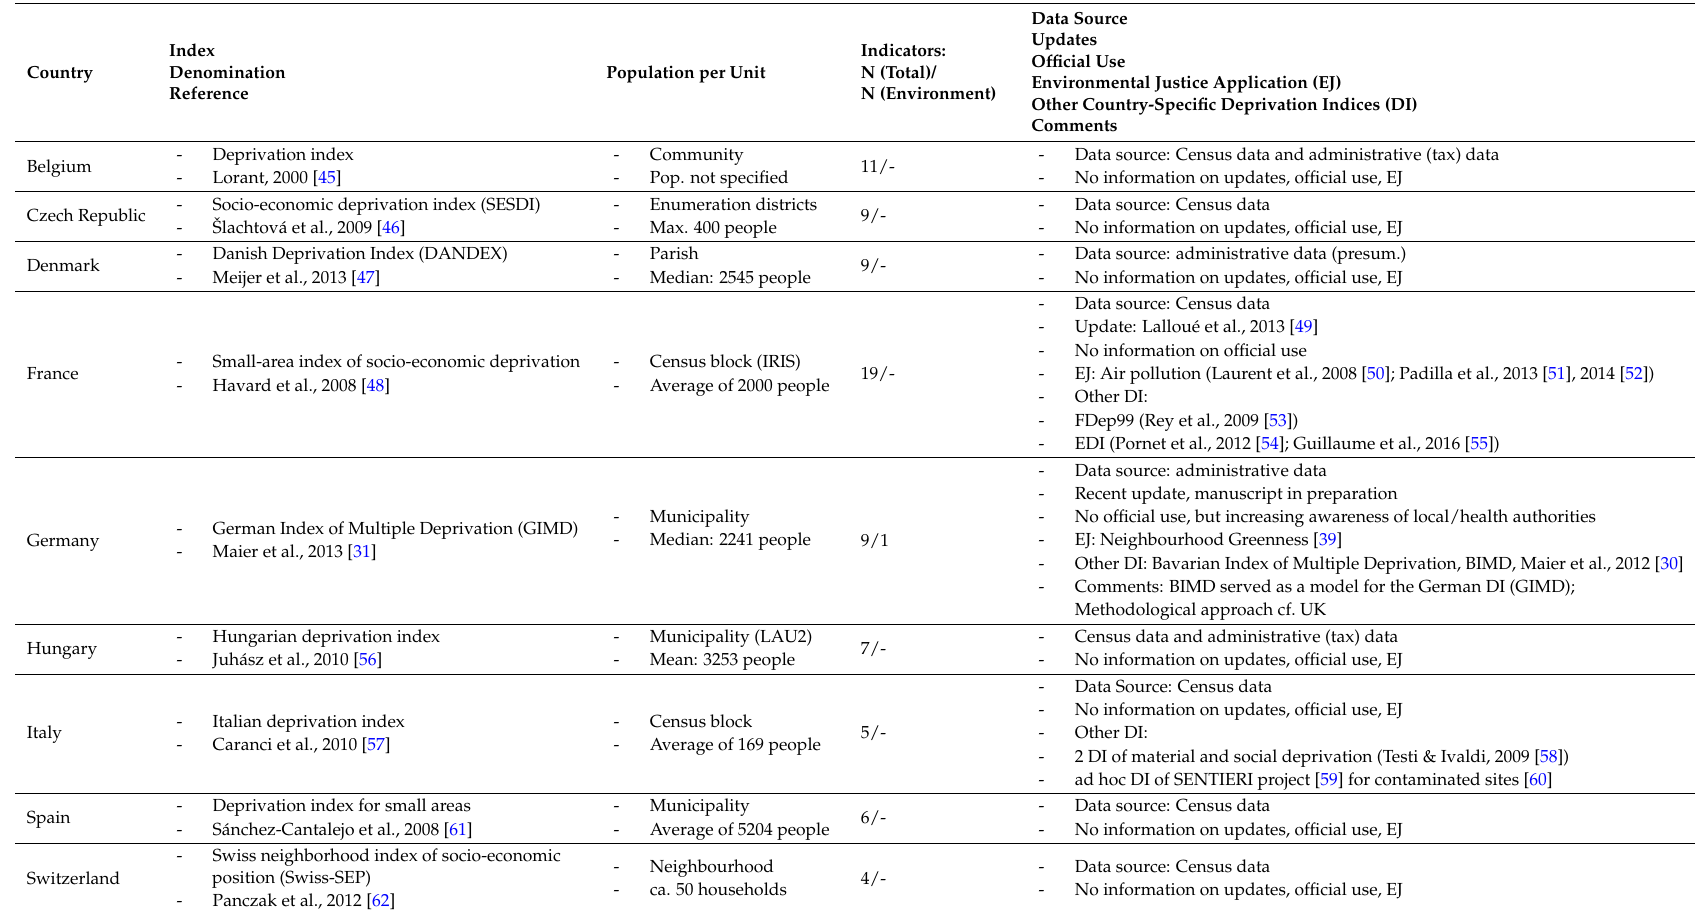
Table 2. Selection of Area Deprivation Indices in